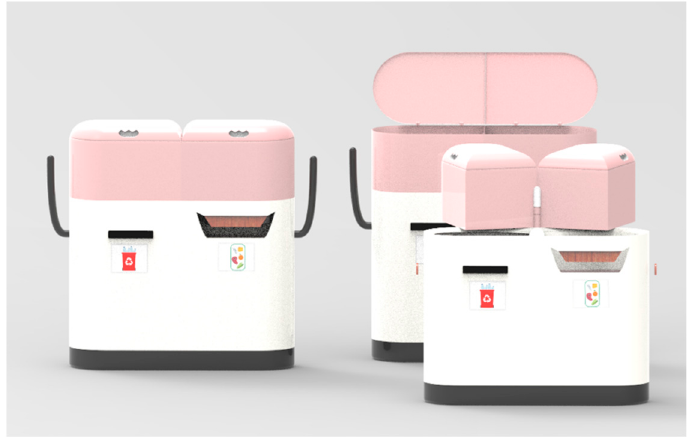
Figure 10. Final conceptual design.